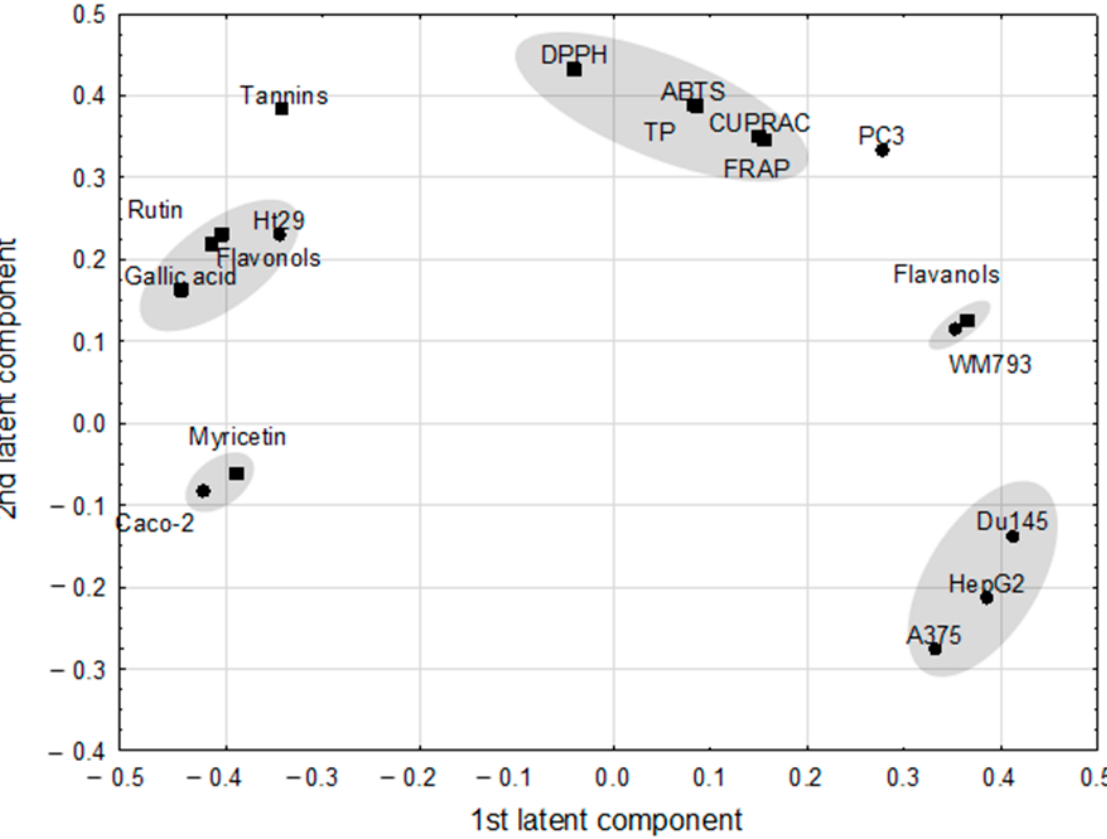
Figure 2. The loadings (coordinates of original parameters, i.e., the weights that combine original parameters with latent components) for first two latent components in the Partial Least Square model. Original parameters with absolute value of their weights higher than 0.3 are considered to be correlated with one another.